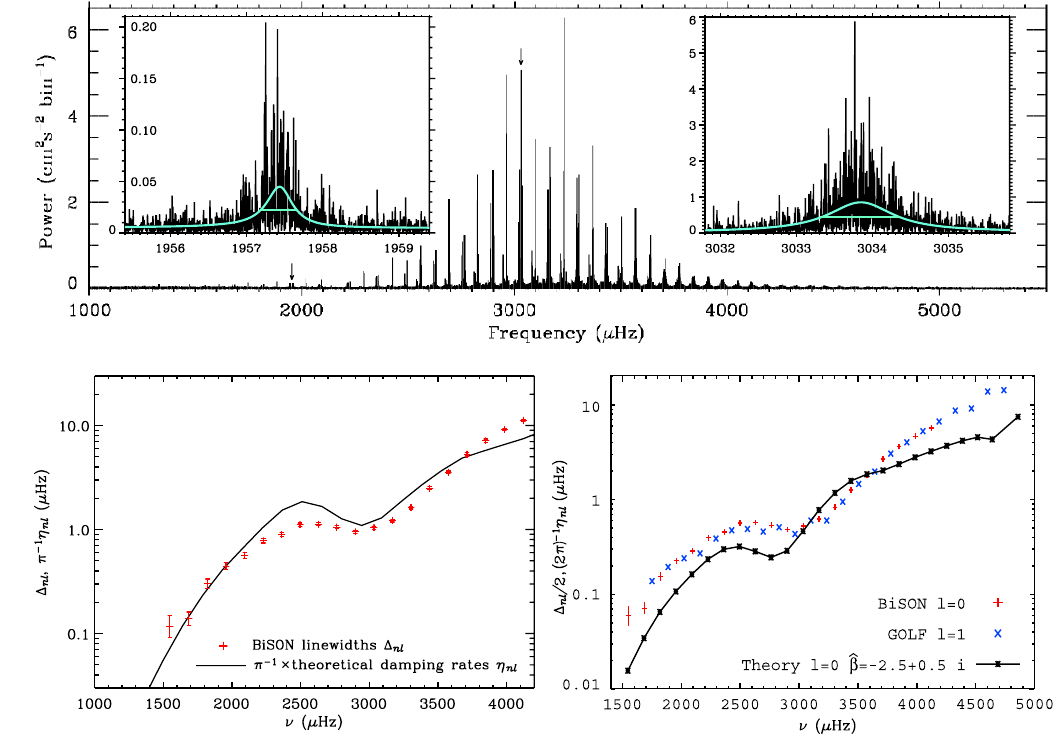
Figure 10: Top: Power spectrum of solar low-degree p modes obtained from a 3456-d data set collected by BiSON (Chaplin et al. , 2005). The two insets show Lorentzian profile fits (and their full-width at half-maximum (FWHM); solid, blue curves) to the spectral peaks of radial modes with order 𝑛 = 13 (left) and 𝑛 = 21 (right); both spectral peaks are indicated by vertical arrows in the power spectrum. Bottom: The symbols in the left-hand panel are the measured BiSON linewidths (we denote the FWHM in units of cyclic frequency by Δ 𝑛𝑙 ) which are compared with the theoretical damping rates 𝜋 − 1 𝜂 𝑛𝑙 (connected by the solid curve) obtained with the nonlocal convection model of Section 3.3 (from Chaplin et al. , 2005). In the right-hand panel theoretical results of (2 𝜋 ) − 1 𝜂 𝑛𝑙 (solid curve) by Dupret et al. (2004a) are compared with observations of Δ 𝑛𝑙 / 2 from the BiSON (red pluses) and the GOLF instrument (blue crosses). A comparison between solar linewidth measurements from the BiSON (Birmingham Solar Os- cillation Network) and from the GOLF (Global Oscillations at Low Frequency) instrument